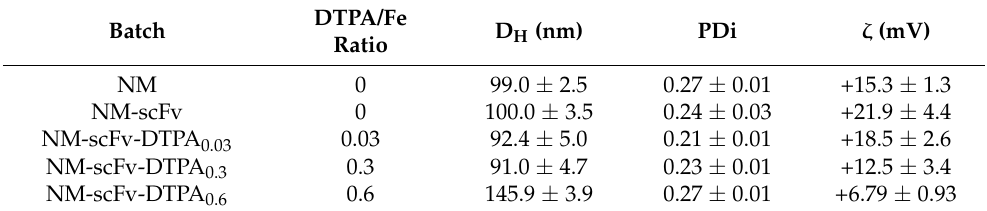
Table 3. Physico-chemical properties of NM-scFv made of different